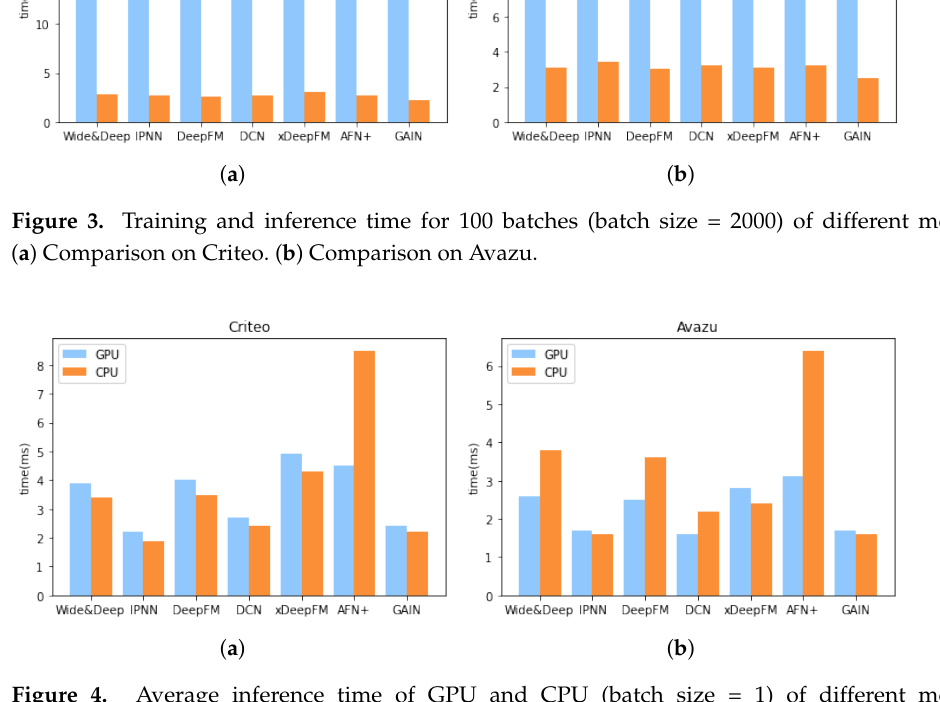
Figure 4. Average inference time of GPU and CPU (batch size = 1) of different models. ( a ) Comparison on Criteo. ( b ) Comparison on